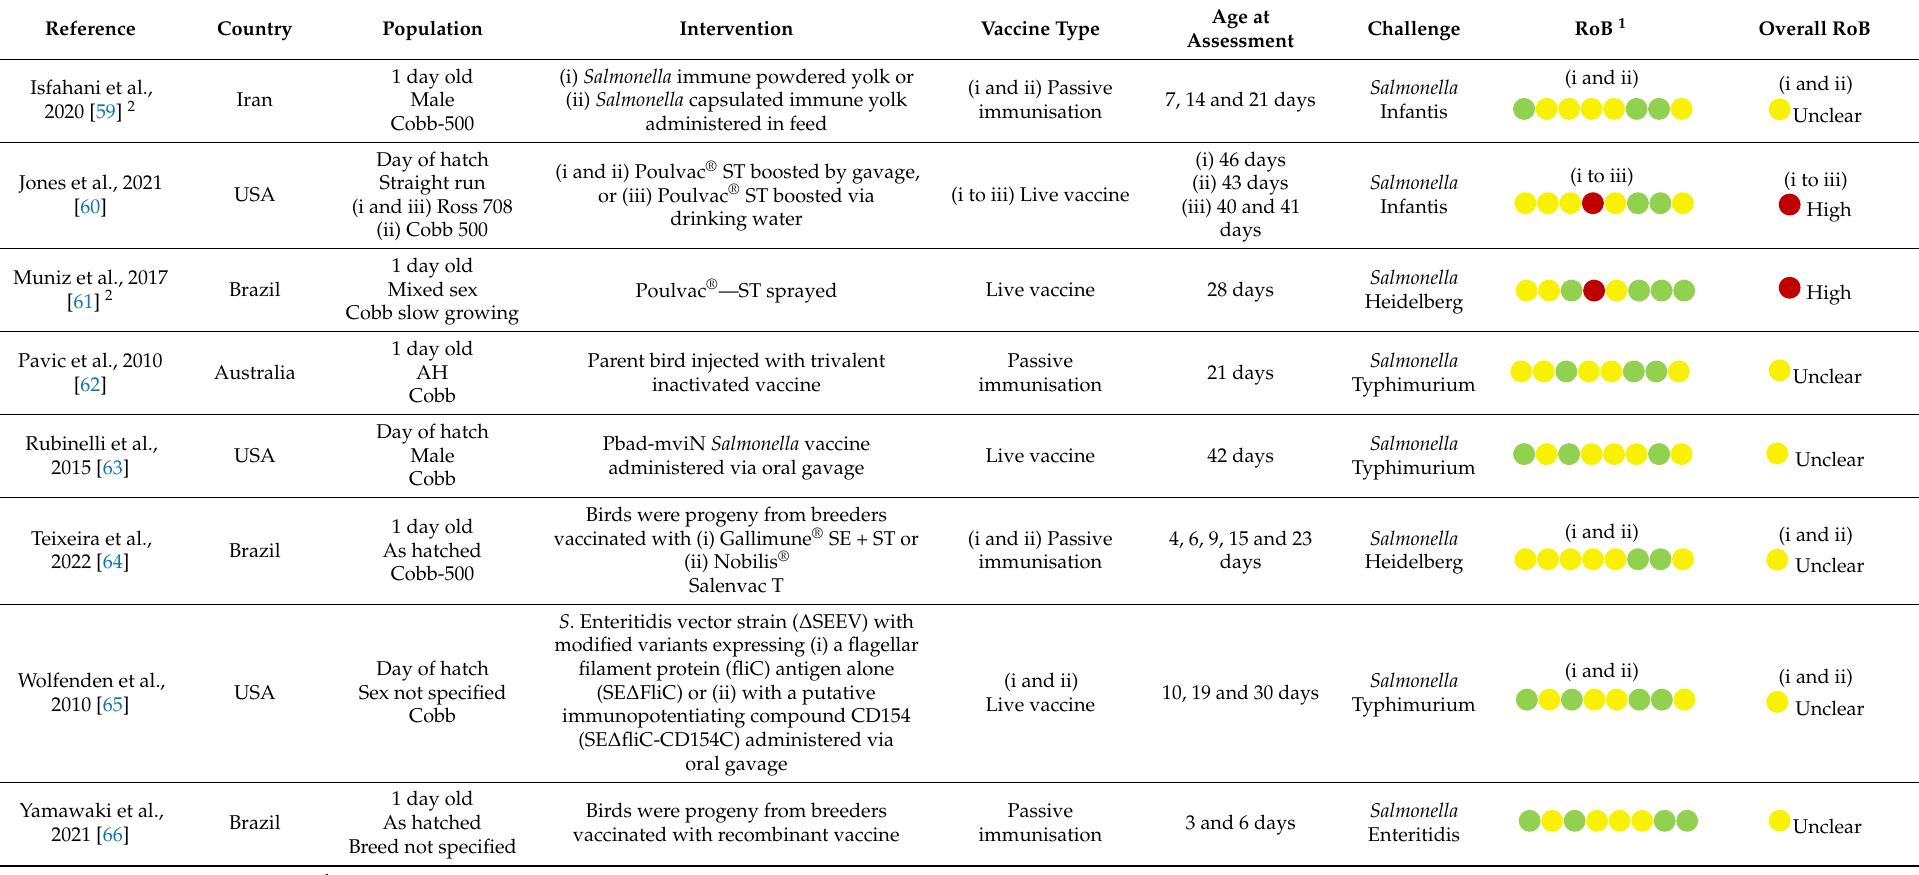
Campylobacter vaccines on caeca Table 2. Summary of key characteristics of studies that investigated the effects of